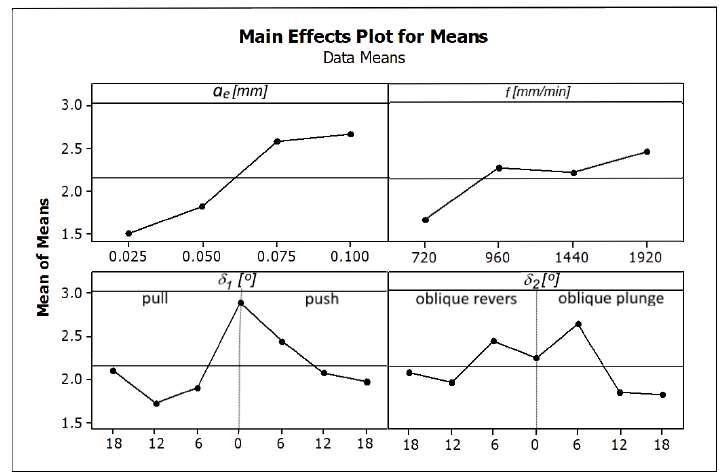
Figure 6. The influence of the analyzed factors on the means values of the surface roughness parameter Ra.